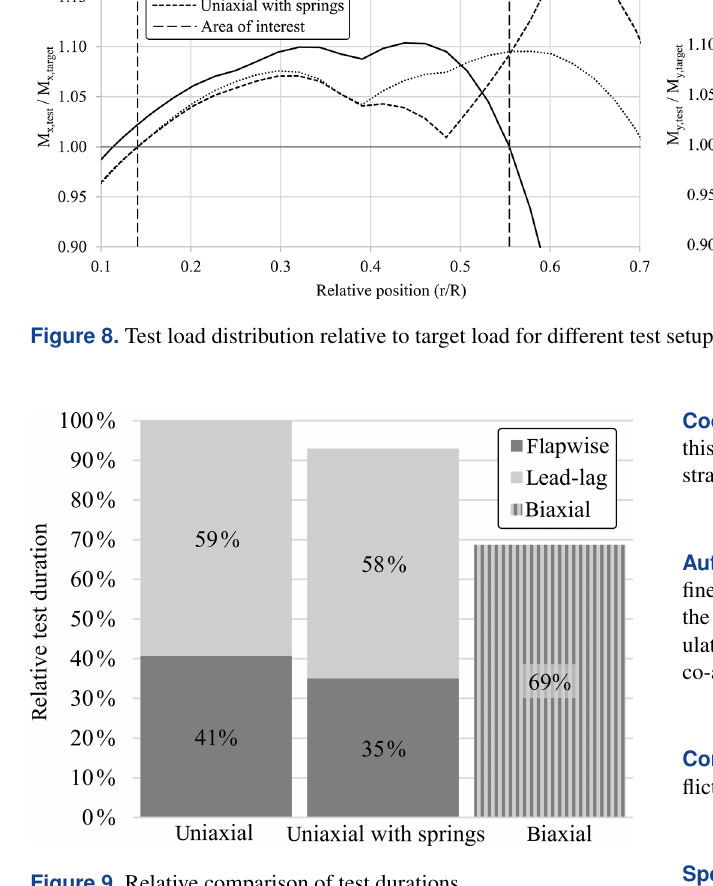
Figure 9. Relative comparison of test